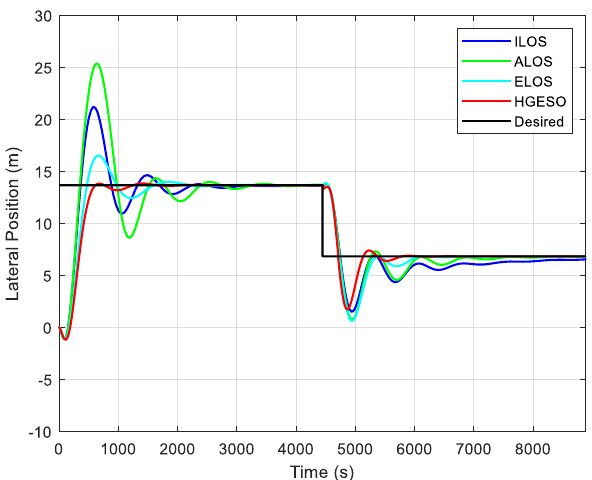
Figure 10. Comparison of lateral position with different guidance laws at varying desired paths.